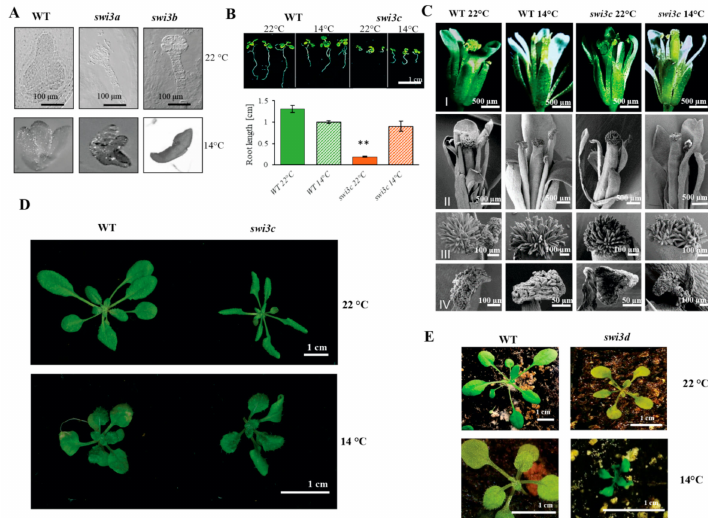
Figure 1. Phenotypic Characterization of Arabidopsis swi3 Mutants Grown at 14 ◦ C. ( A ) Nomarski image of WT, swi3a and swi3b embryos at 22 ◦ C (upper panel) and at 14 ◦ C (lower panel). ( B ) Root phenotype of 14-days-old swi3c line grown at 22 ◦ C and 14 ◦ C. Root length measurement showed that the swi3c mutant plants exhibited partial reversion of root elongation defect at 14 ◦ C. (**): Significantly di ff erent at p < 0.01 according to t-test, three biological replicates were used, at least ten plants from each genotype were measured. ( C ) Appearance of mature flowers (I) and analysis of their organs (II) including stigma (III) and anther (IV) by scanning microscopy in WT and swi3c plants